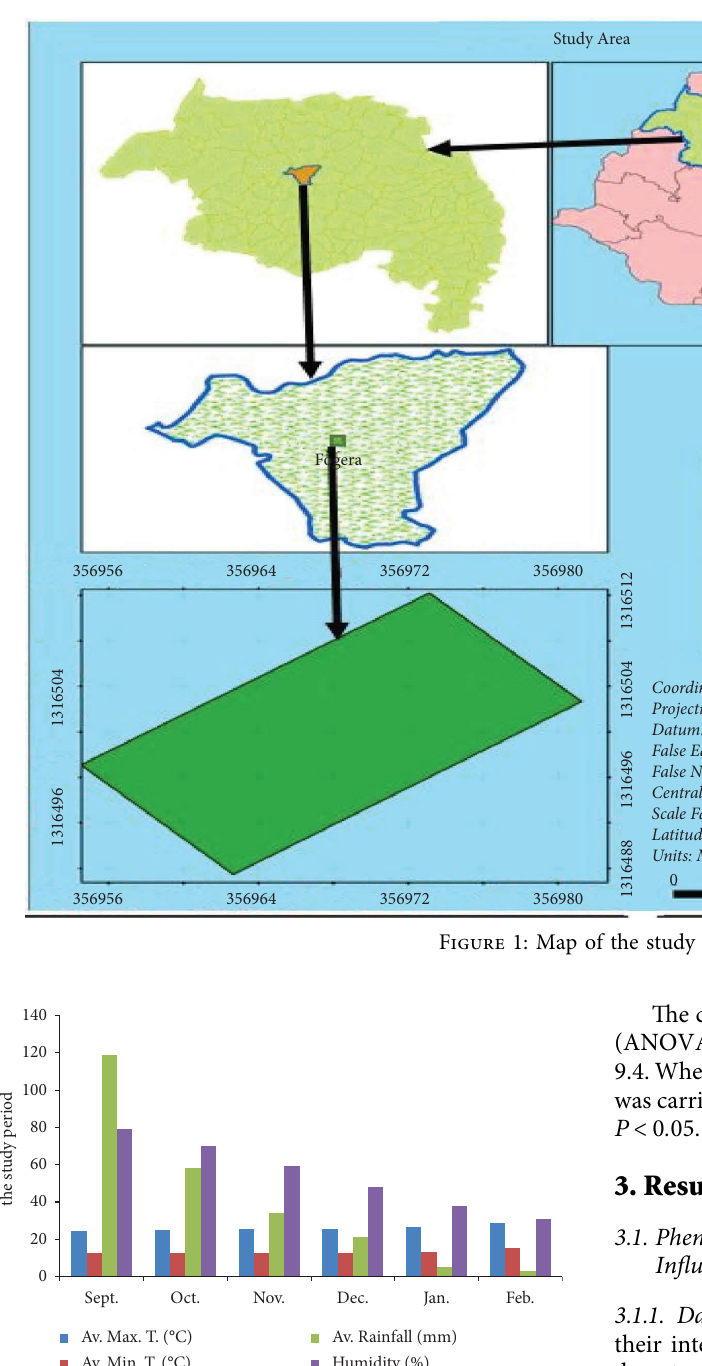
Figure 2: Average monthly metrological data of Fogera district during the study